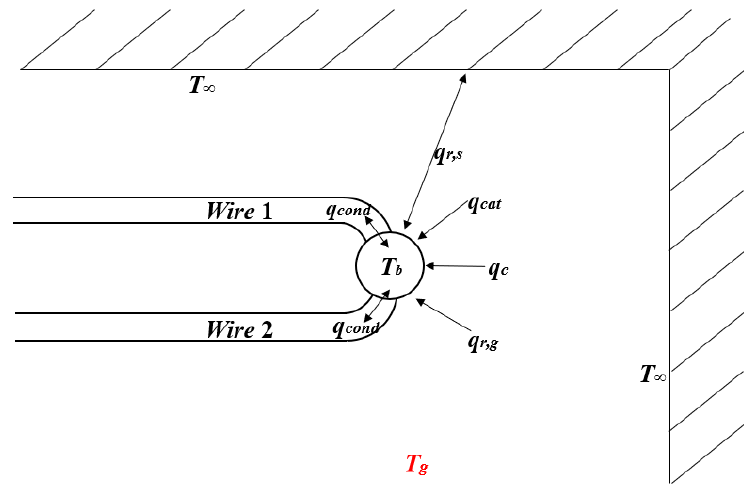
Figure 1. Schematic of bead energy balance.